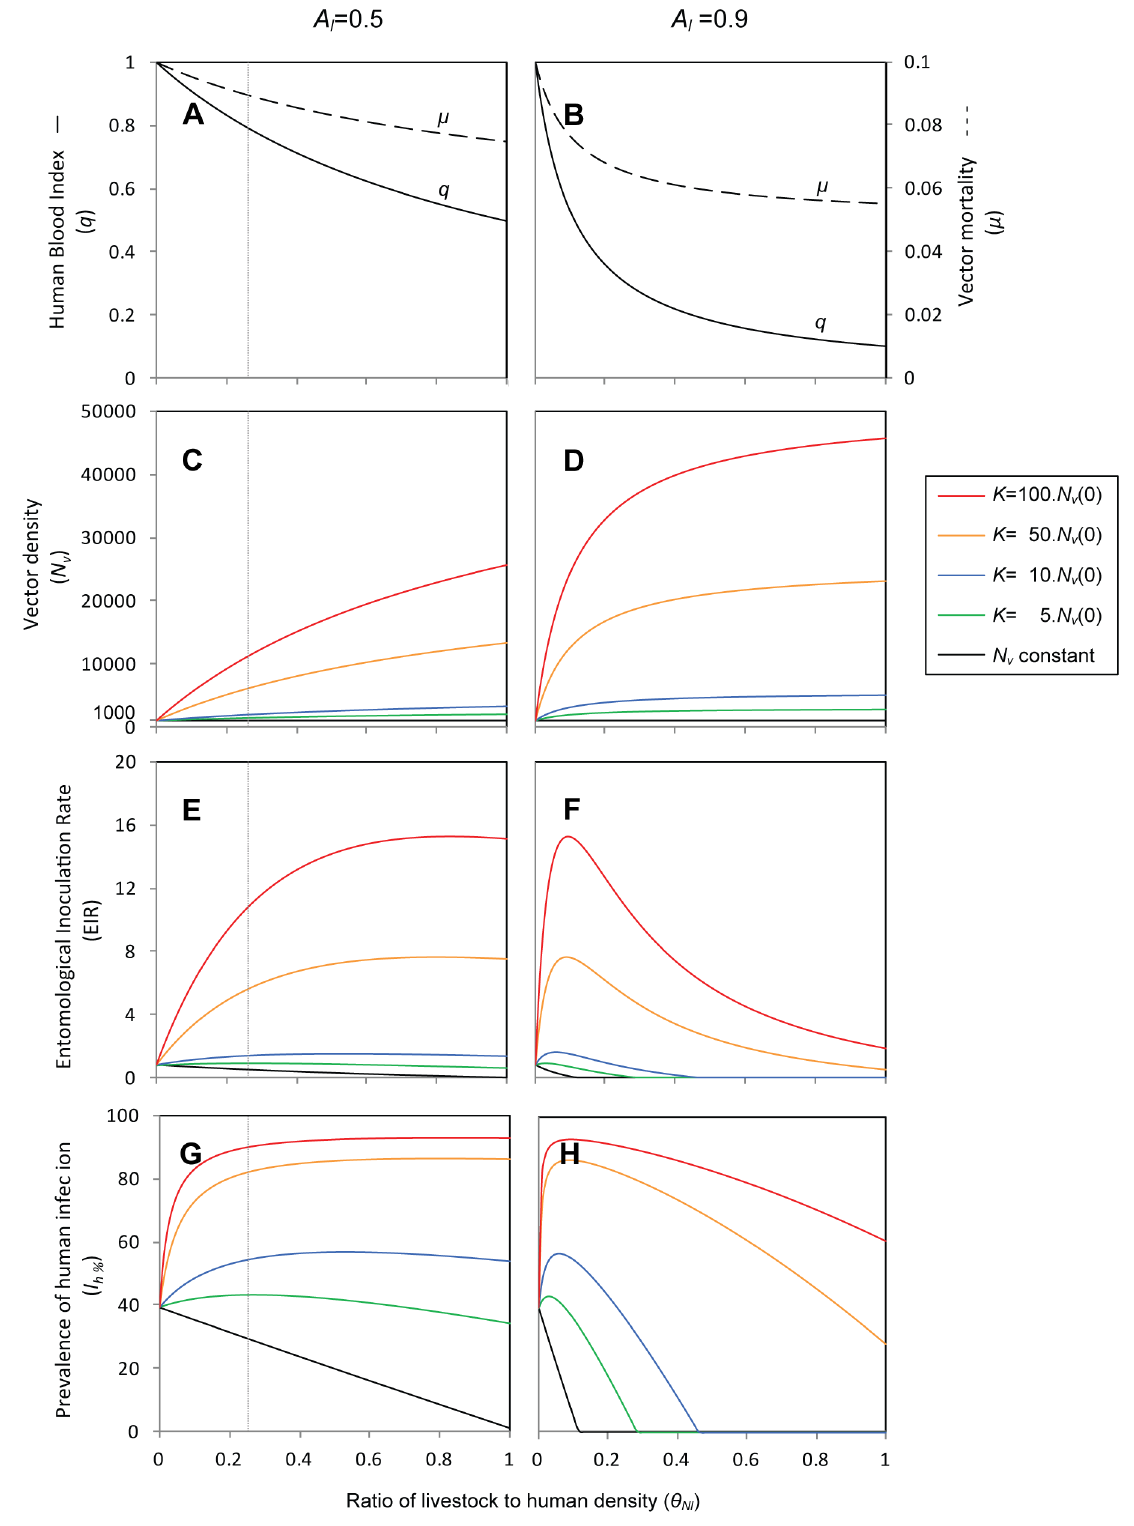
Figure 3. Effect of altering the relative livestock to human density, for different vector density scenarios, at the new endemic equilibrium. Comparing a scenario where the availability of livestock to vectors is the same as that of humans (left, A l =0.5) versus where it is 9 times higher than that of humans (right, A l =0.9). Along the x -axis, representing h Nl = N l /N h , the livestock density N l is varied relative to a fixed human density N h =100. N v (0)=1000. Effect of introducing livestock when: N v remains constant (black line), and when N v increases until reaching a maximum, which depends on the carrying capacity, K (coloured lines: K increasing from 5,000 (green line) to 100,000 (red line)). The effects of introducing livestock on the human blood index (HBI) and on the vector mortality rate ( m ) are independent from the vector density scenarios (A, B).